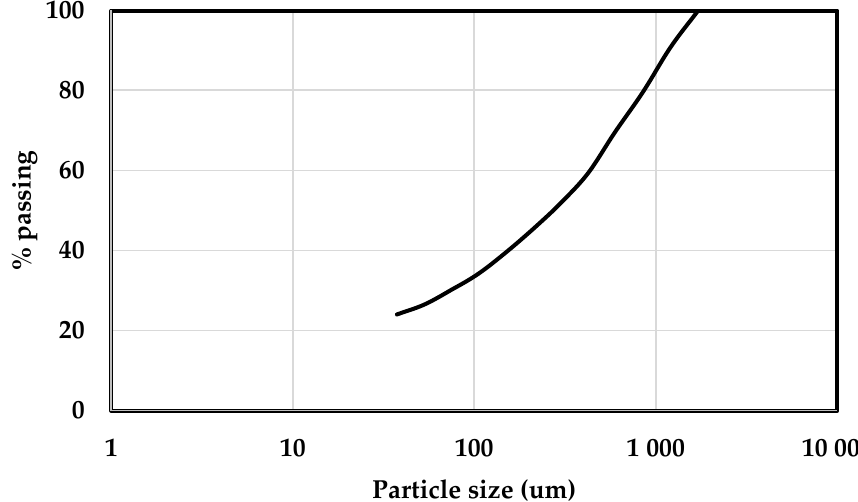
Figure 3. Size distribution of the residue.